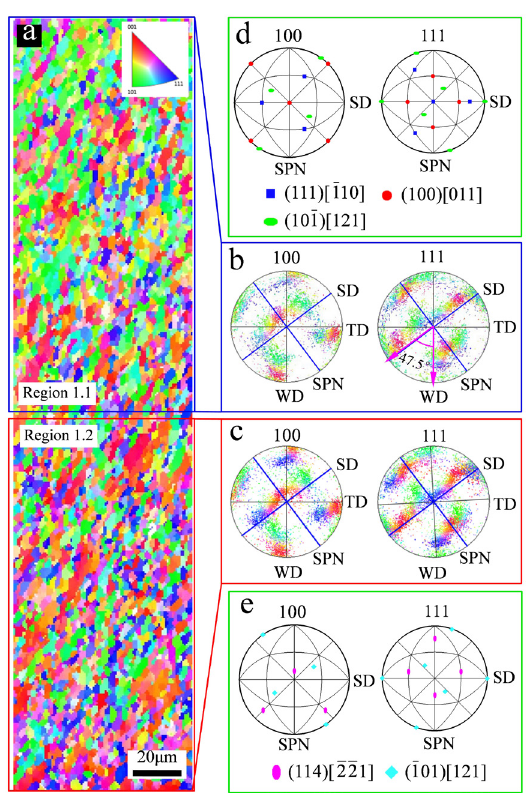
Figure 6. EBSD images of grain morphology and the pole of region 1. (a) grain morphology, (b) 100 and 111 pole figures of region 1.1, (c) 100 and 111 pole figures of region 1.2, and (d)–(e) exact pole figures.